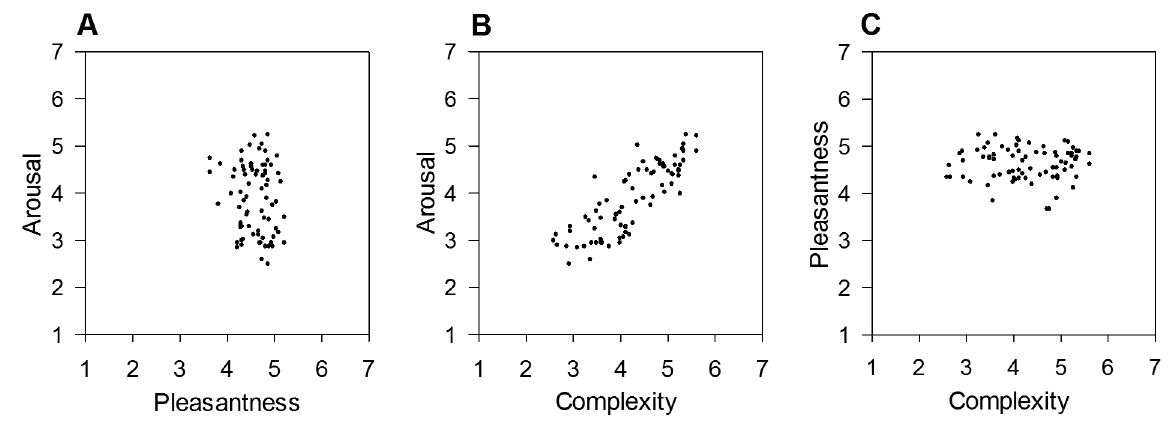
Figure 4. Relationships between pleasantness, arousal and complexity in a set of piano solo and chamber music excerpts. Low numbers refer to low ratings of pleasantness, arousal and complexity, respectively. A) Distribution of Romantic piano solo music and piano trio excerpts in the pleasantness-arousal space. B) Relationship between mean complexity and arousal ratings. C) Relationship between mean complexity and pleasantness ratings. doi: